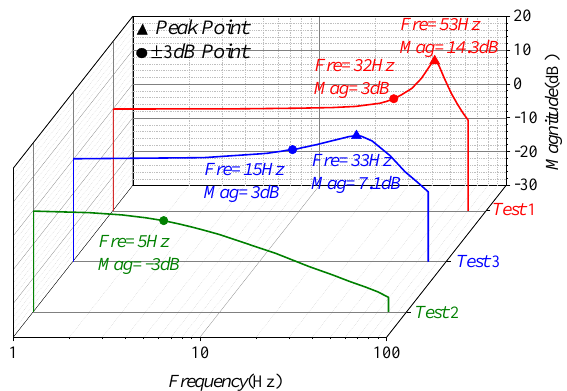
Figure 16. Gyroscope bandwidth under the three test